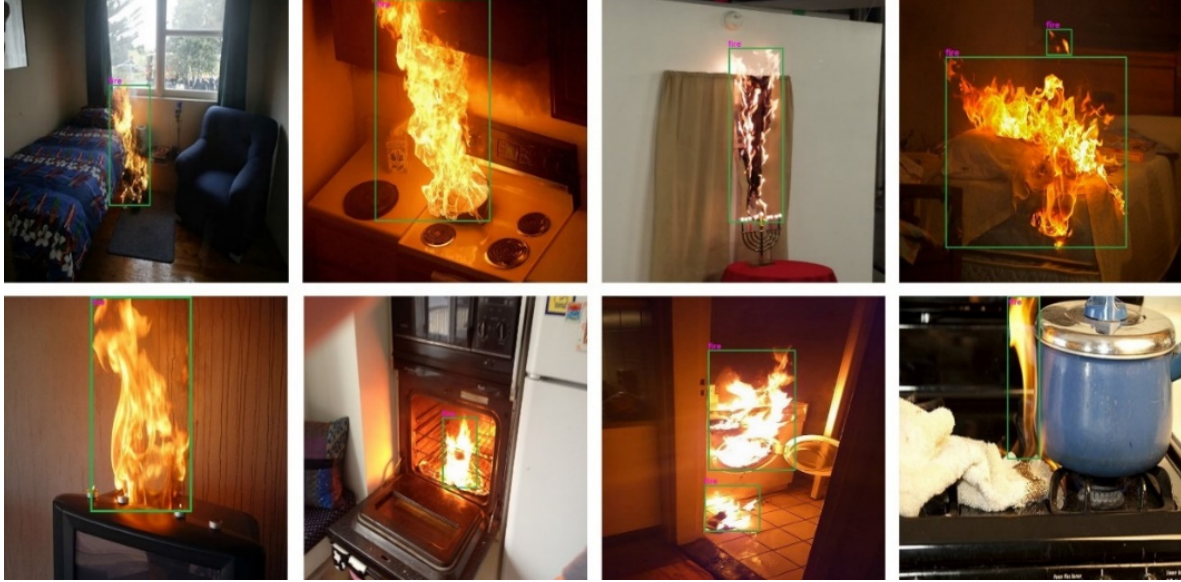
Figure 9. Visual results of the proposed fire detection system for various indoor environments.